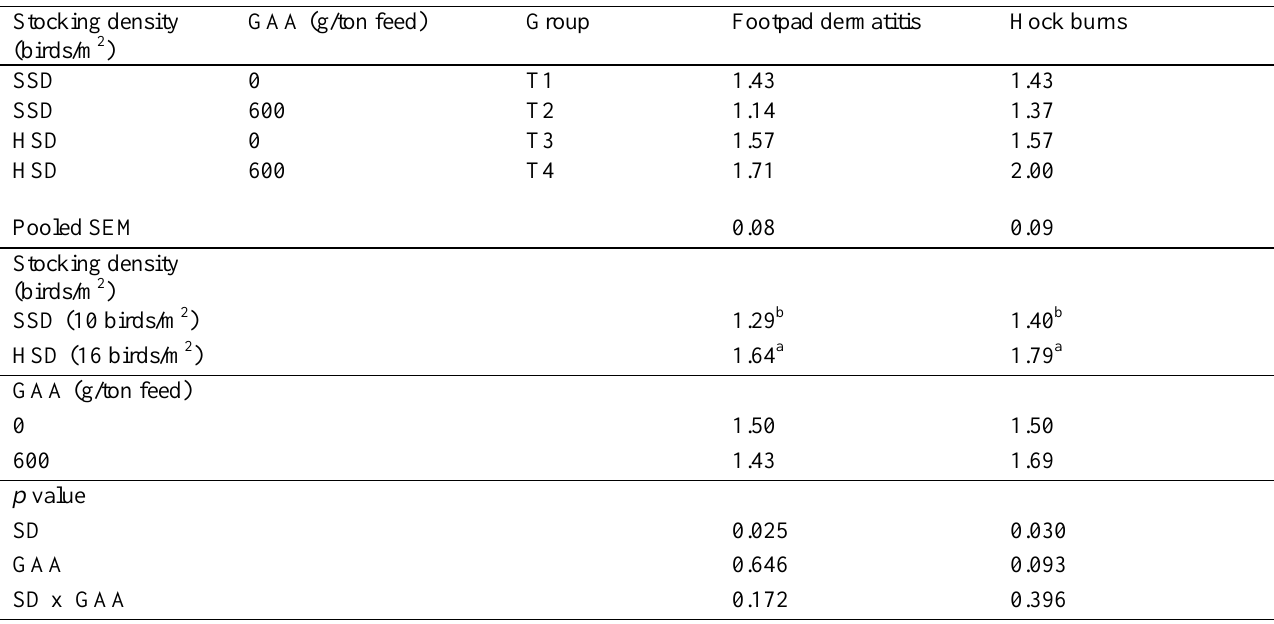
Table 4: Effect of stocking density and GAA supplementation on welfare indicators (Footpad dermatitis and Hock burns